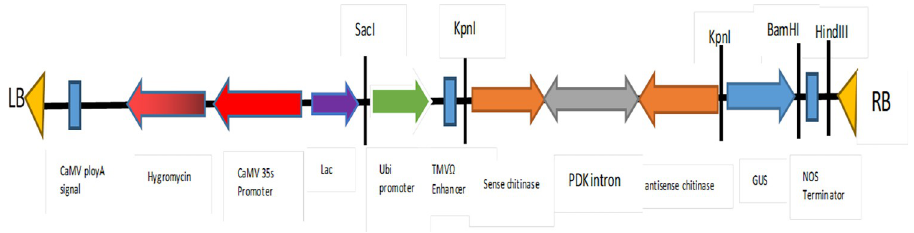
Fig 1. Schematic illustration of the T-DNA vector used for maize transformation. Pyruvate orthophosphate dikinase (PDK) intron of 767bp introduced between the sense and antisense chitinase sequence was driven by poly Ubi maize promoter and TMV omega enhancer to increase transgene